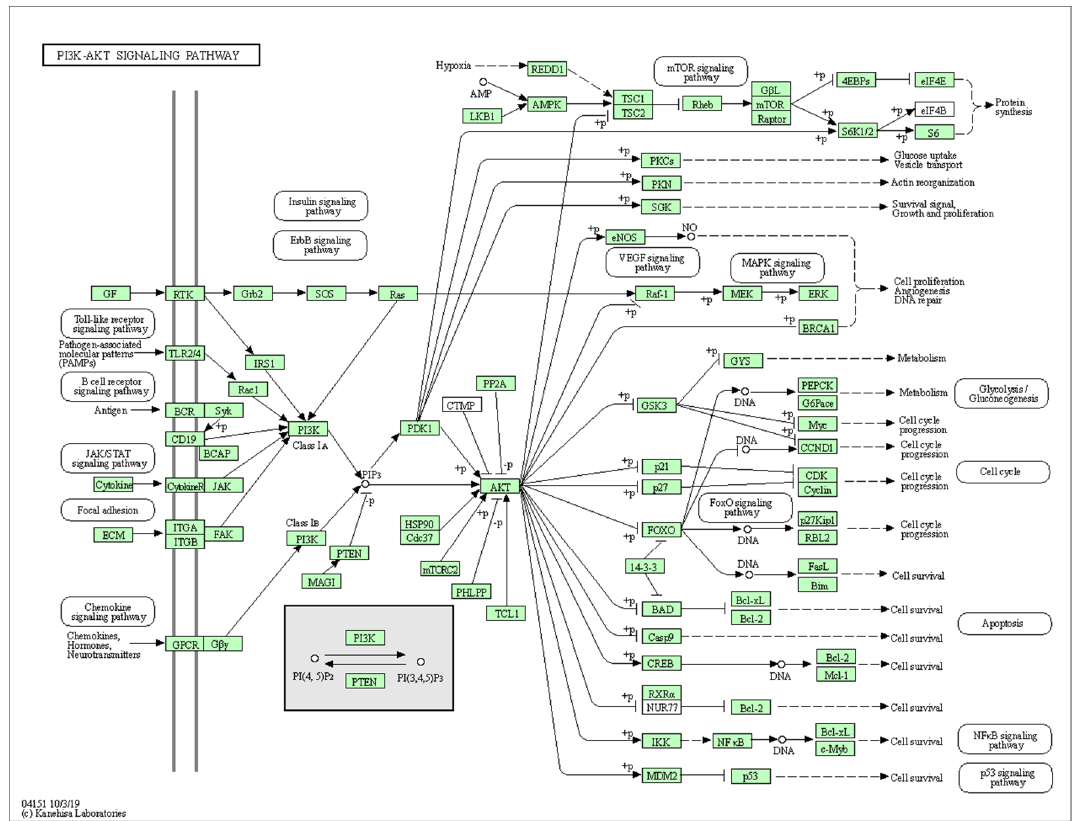
Figure A5. PI3K-AKT signaling pathway, KEGG pathway. KEGG, Kyoto Encyclopedia of Genes and Genomes. Copyright permission obtained.